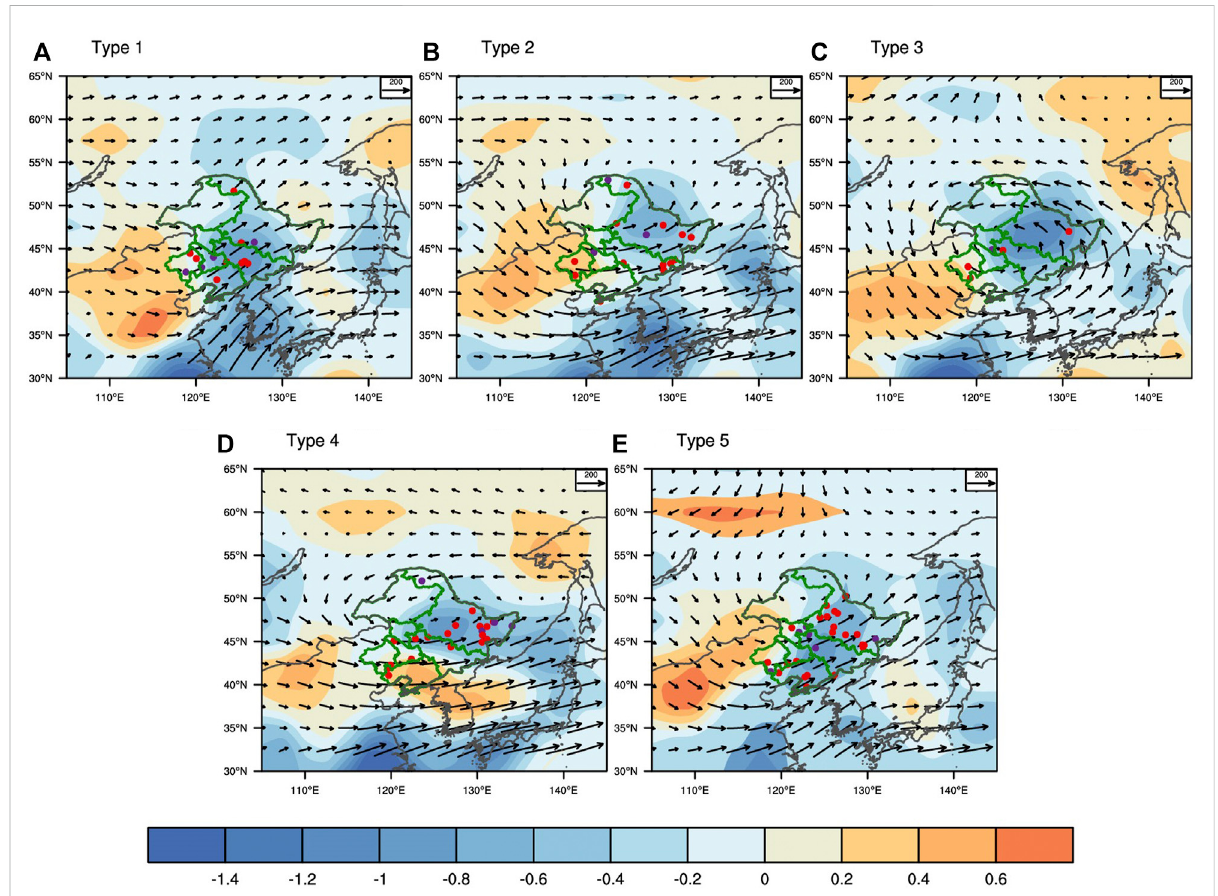
FIGURE 9 Watervapor fl uxesofthewholeatmospherelayer(vector,units:kg m − 1 s − 1 )anditsdivergence(shaded,units:10 − 4 kg m − 1 s − 1 )under fi vetypesof synoptic circulation patterns (A-E) . The red dots represent the accumulated precipitation of rainstorm days associated with NECVs in this type accounts for 50% – 80% of all accumulated precipitation of rainstorm days associated with NECVs and the purple dots represent equal to or greater than 80%. The green map denotes the